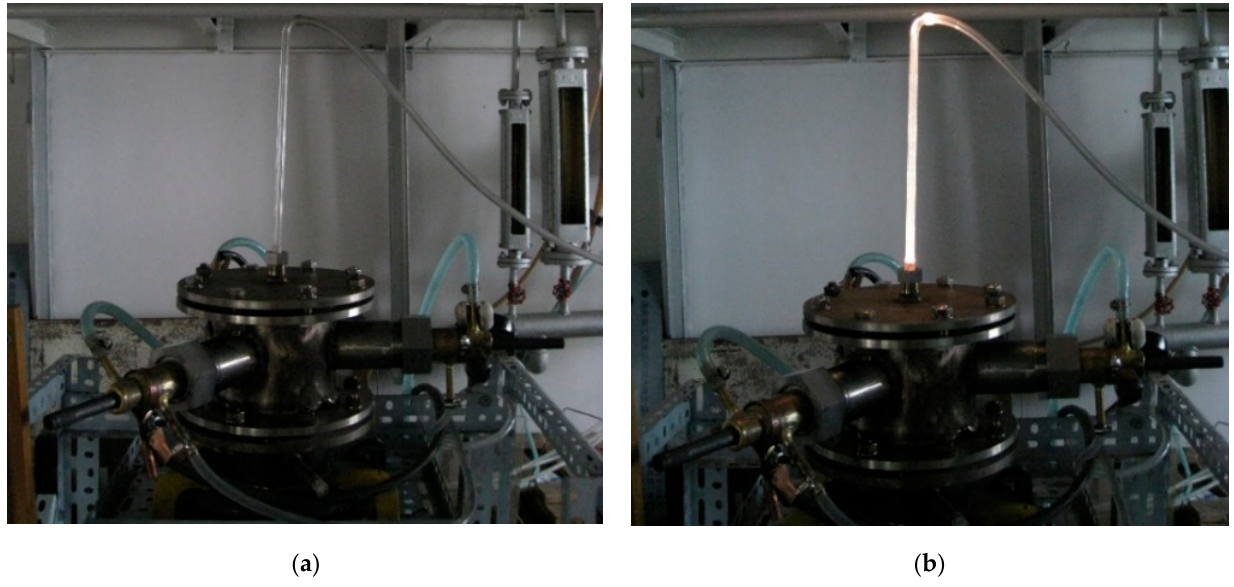
Figure 2. Photos of the three-phase AC arc plasma setup before ( a ) and after ( b ) arc ignition.